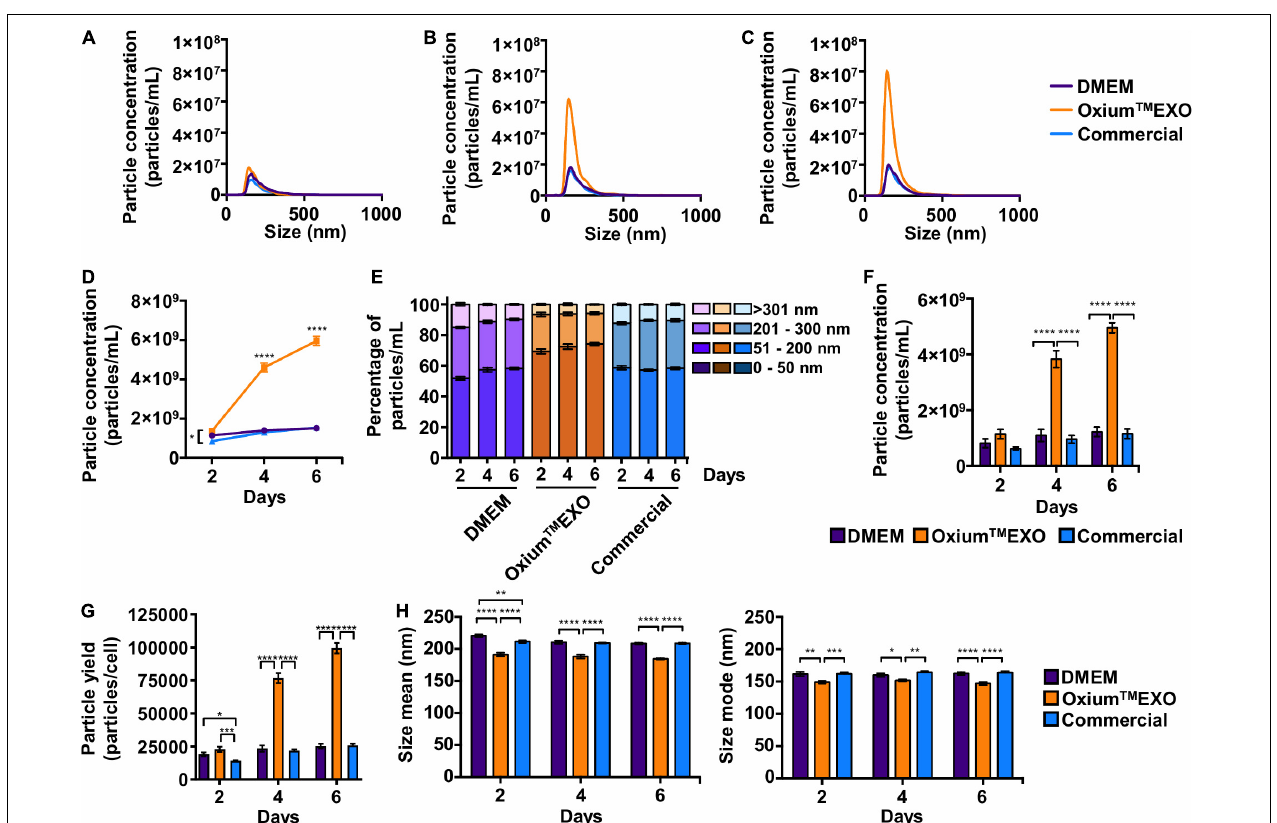
FIGURE 2 | Comparative particle secretion assessment in UC-MSCs cultured in DMEM, Oxium TM EXO, and commercial medium for sEV production. Conditioned media were collected at 2, 4, and 6 days post-induction and analyzed by NTA to assess the particle secretion capacity of cells cultured in DMEM, Oxium TM EXO, and commercial medium. The graphs show the particles’ concentrations according to their size after (A) 2 days, (B) 4 days, and (C) 6 days post-induction. (D) Total particles’ concentration found after 2, 4, and 6 days post-induction with the different media. (E) Percentage distribution of particles’ concentrations according to their size: 0–50 nm, 51–200 nm, 201–300 nm, and > 301 nm. (F) Concentrations of particles in the size range of 51–200 nm. **** P < 0.0001, two-way ANOVA, followed by Tukey’s comparison test. (G) Number of particles produced by cells in the different media at 2, 4, and 6 days, respectively. (H) Particle size’s mean and mode obtained in the different media at 2, 4, and 6 days, respectively. ** P < 0.01, **** P < 0.0001, two-way ANOVA, followed by Tukey’s comparison test. (A–C) Graphs show the mean of particle concentrations of five independent-recorded NTA videos. (D–H) Graphs show mean ± SEM, n =